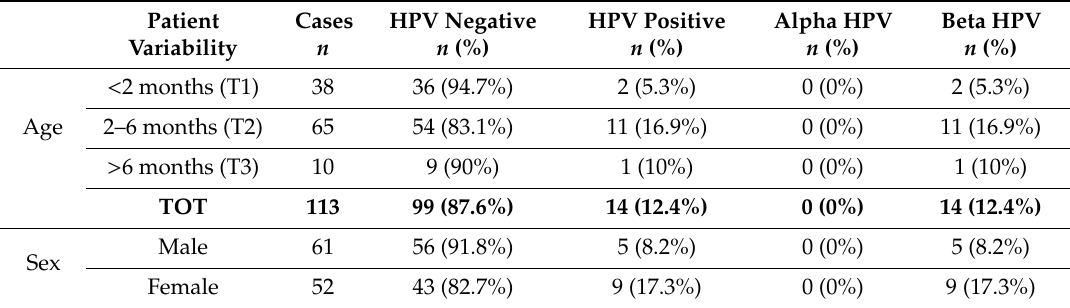
Table 1. Baseline information of the 113 children included in the study and human papillomavirus (HPV) detection results.